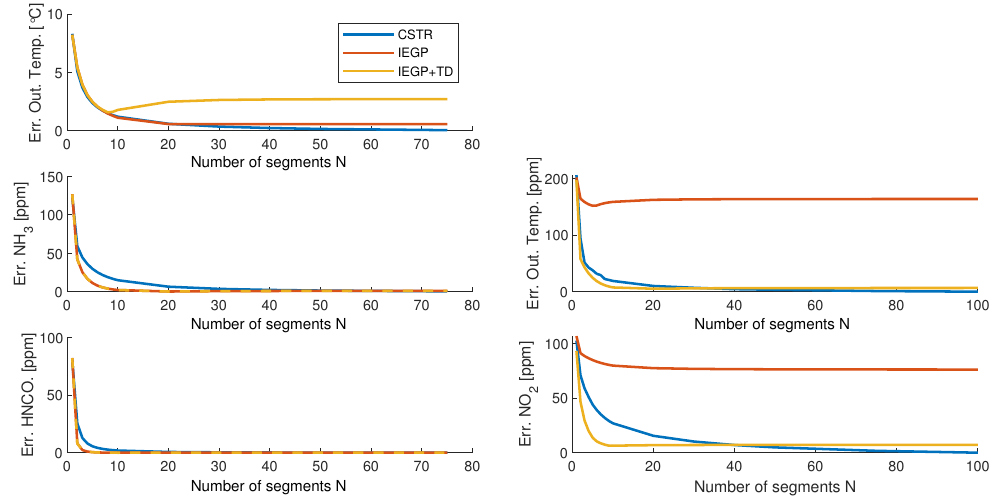
Figure 6. Maximal instantaneous error for all outputs among all models and different N . For the IEGP models, M = 2 and K = 5 were used. The CSTR with N = 100 was used as reference.